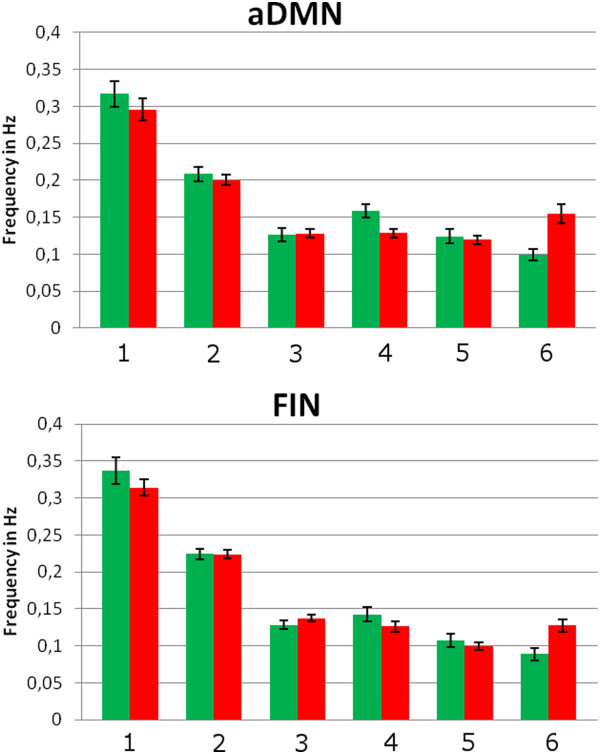
Power spectra of patients (red) and healthy controls (green). Intrinsic neural activity within the aDMN and the FIN show faster spontaneous fluctuations in patients with chronic pain disorder. Error bars represent the standard error of the mean. [1 ≡ 0–0.04 Hz, 2 ≡ 0.04 - 0.08 Hz, 3 ≡ 0.08 - 0.12 Hz, 4 ≡ 0.12 - 0.16 Hz, 5 ≡ 0.16 - 0.20 Hz, 6 ≡ 0.20 - 0.24 Hz].